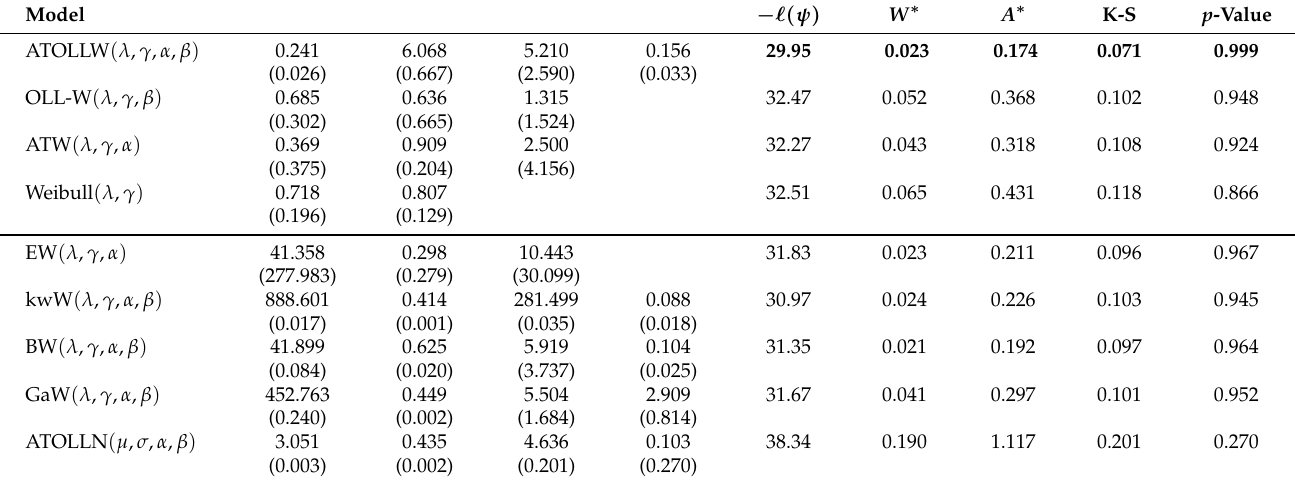
Table 3. A summary of model fitting to the windshield device